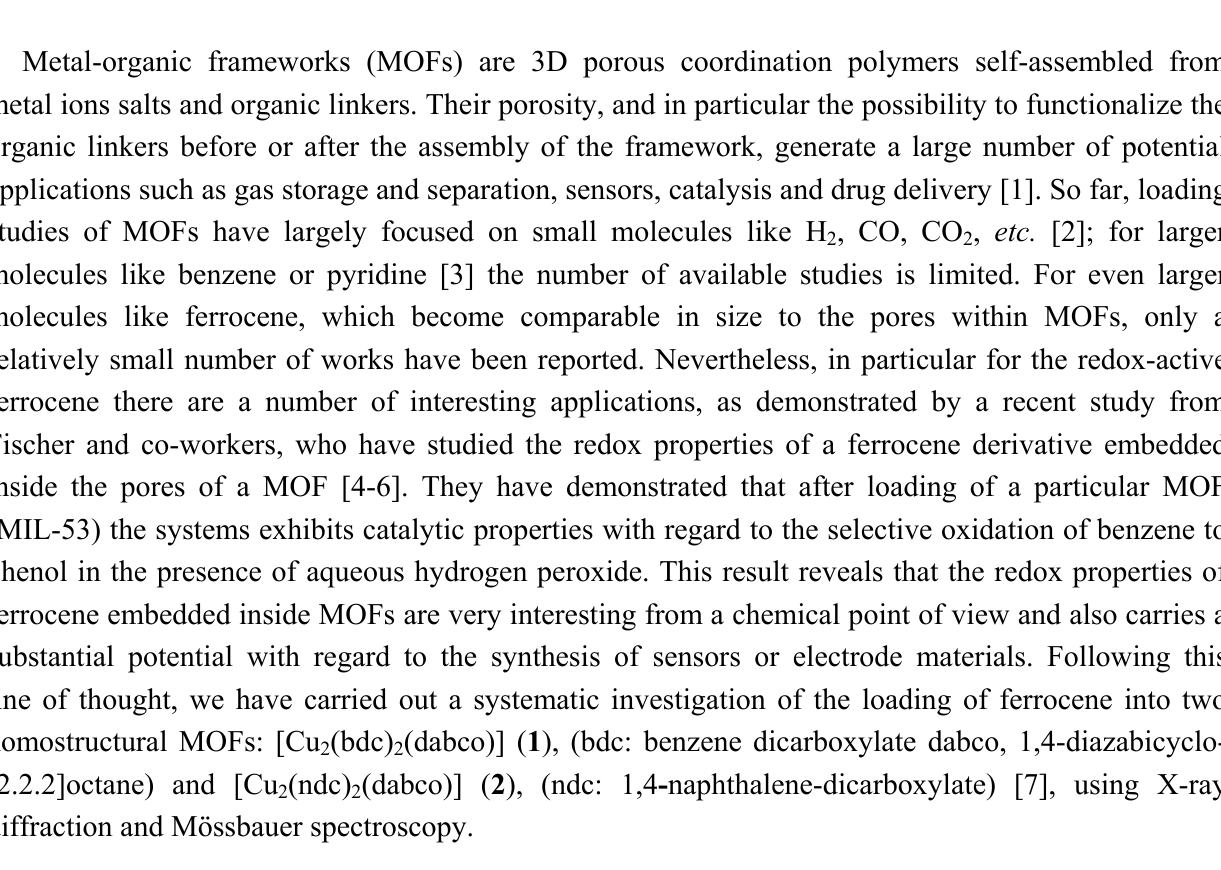
Table 1. Evaluation of the ferrocene content inside [Cu